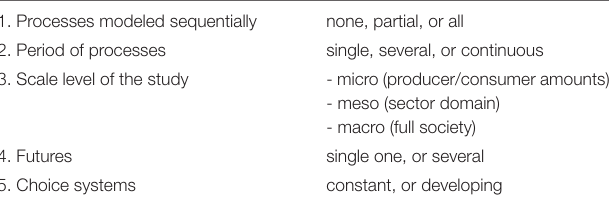
TABLE 3 | Five basic characteristics of product-technology models, with their